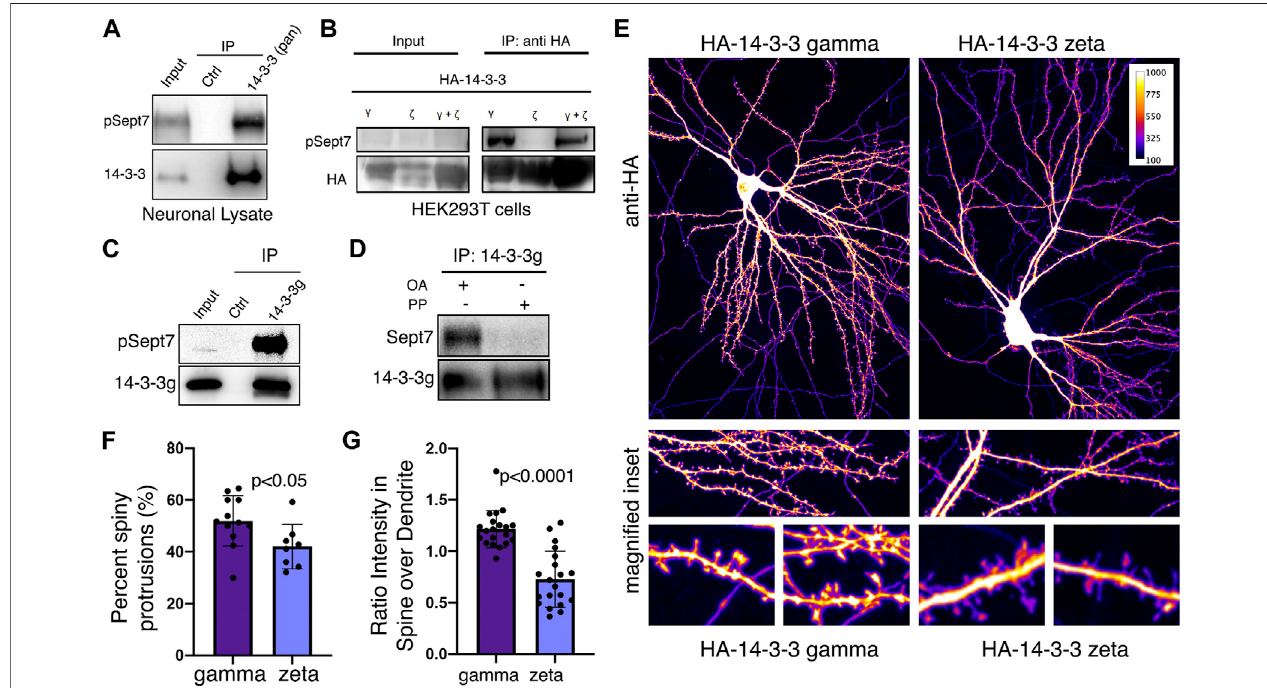
FIGURE 4 | 14-3-3 γ associates with phosphorylated Sept7 and enhances dendritic spine maturation. (A) Western blot of endogenous 14-3-3 protein in DIV18 hippocampalneuronsimmunoprecipitatedwith14-3-3(pan)antibodyandprobedfor14-3-3andphosphorylatedSept7(pT426)( n =3experiments). (B) Westernblotof HA-14-3-3 γ ,HA-14-3-3 ζ ,or bothHA-taggedisoformsco-expressedalongwithGFP-Sept7inHEK293T cellsimmunoprecipitatedwithHAantibodyand probedforHA and phosphorylatedSept7(pT426). PhosphorylatedSept7co-immunoprecipitated withHA-14-3-3 γ andHA-14-3-3( ζ + γ )but notHA-14-3-3 ζ ( n =3experiments). (C) Westernblotshowscoimmunoprecipitation ofphosphorylatedSept7withendogenous14-3-3 γ .Lysatefrom DIV18hippocampalneuronsimmunoprecipitatedwith 14-3-3 (gamma)antibody and probed for 14-3-3 γ and phosphorylated T426Sept7( n = 3experiments). (D) Westernblotshows phosphorylationdependent interaction of Sept7 with endogenous 14-3-3 γ . DIV18 hippocampal neurons were treated with okadaic acid (OA) or DMSO, and lysate treated with or without lambda protein phosphatase (PP)were then immunoprecipitated with 14-3-3 (gamma) antibody and probed for 14-3-3 γ and total Sept7 ( n =3 experiments). (E) Fixed images ofDIV14 hippocampal neurons co-transfected with membrane marker myristoylated tdTomato and HA-14-3-3 γ or HA-14-3-3 ζ were immunostained for HA tag. Scale bar is 10µm,andimagepsuedocoloredtorepresent fl uorescenceintensity. (F) Bargraphdepictspercentofprotrusionswithmature,spinymorphologyinDIV14hippocampal neurons transfected with HA-14-3-3 γ or HA-14-3-3 ζ . HA-14-3-3 γ expression results in signi fi cantly more spiny, mature protrusions ( p < 0.05). Values indicate mean, errorbarsrepresentSEMand n > 8neuronseach. (G) Bargraphshowsratioof14-3-3 fl uorescentintensityinspinestointensityincorrespondingdendriticshaftinDIV14 hippocampal neurons transfected with HA-14-3-3 γ or HA-14-3-3 ζ . Values indicate mean percent, error bars represent standard error of mean, and n = 20 spines from fi ve neurons